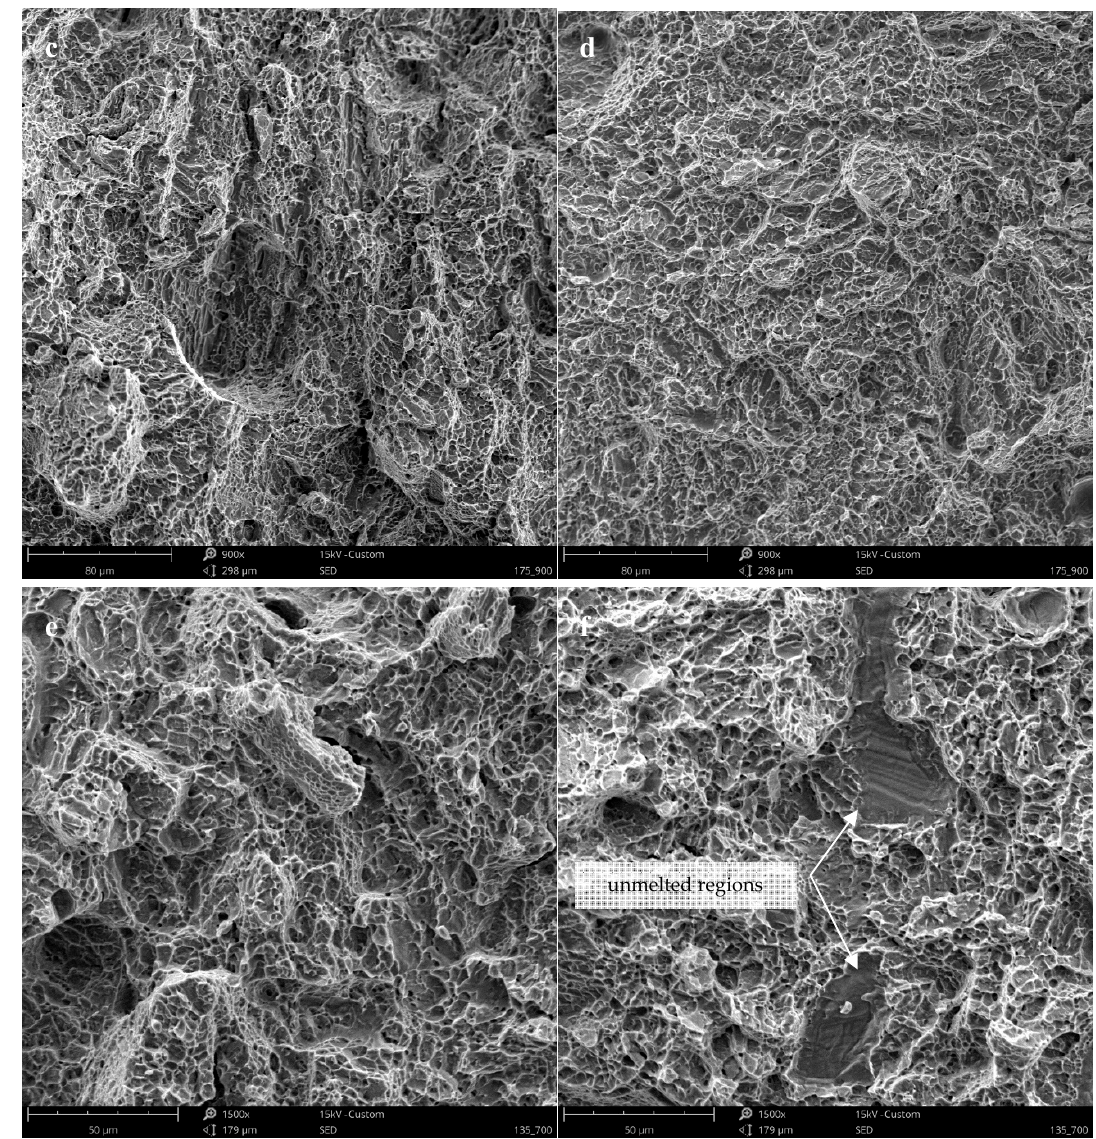
Figure 8. Fracture surface of non-treated ( a , b ) and heat treated ( c – f ) vertically ( a , c , e ) and horizontally ( b , d , f ) oriented samples; mag. 900 × and 1500 ×.